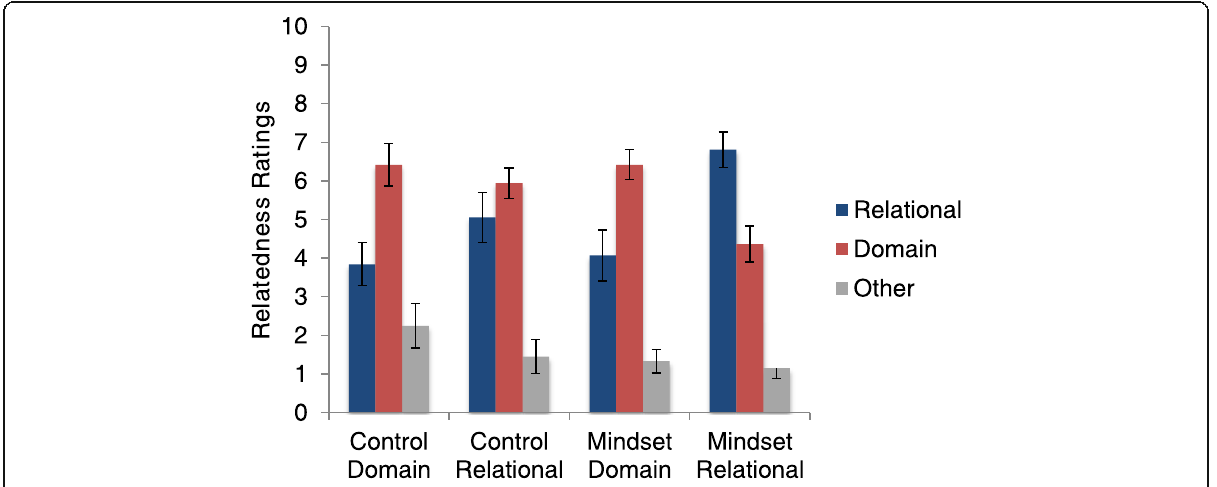
Fig. 4 Means (and standard errors) of relatedness ratings in the text-mapping task in experiment 2. Original scale was 0 – 100